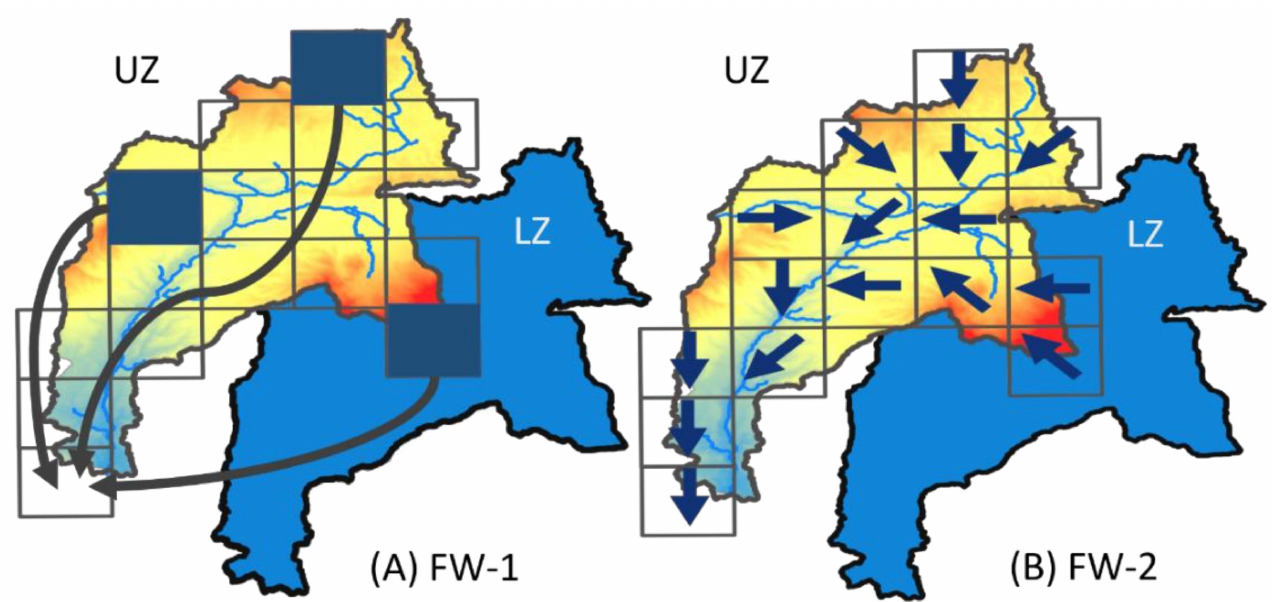
Figure 2. Two variants of raster-based conceptual distributed models (of type 2): ( A ) FW-1 routes the discharge directly to the outlet using Maxbas function, and ( B ) FW-2 routes the discharge from one cell to another following the river network using the Muskingum